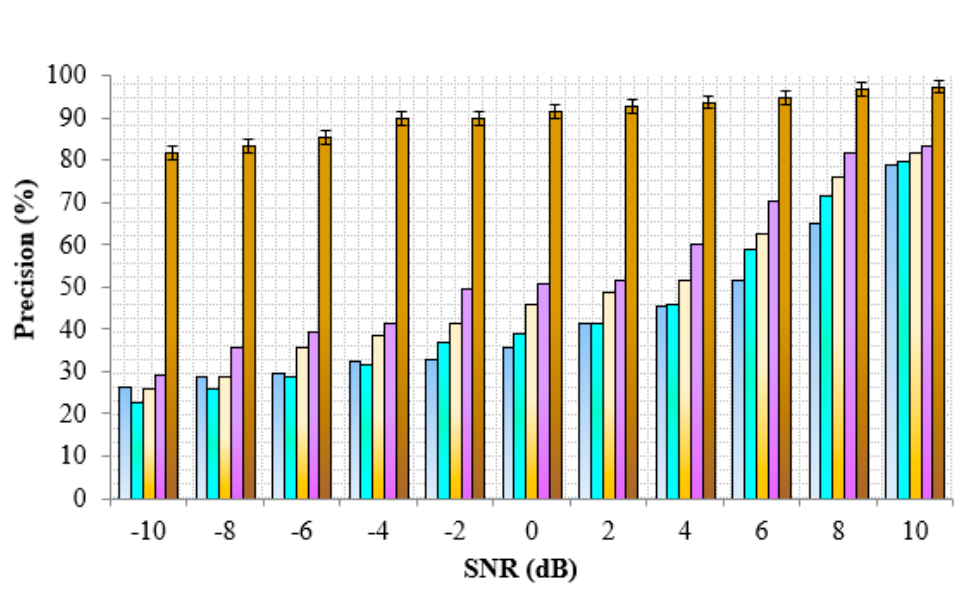
Figure 14. Comparison of precision (Scenario 2).